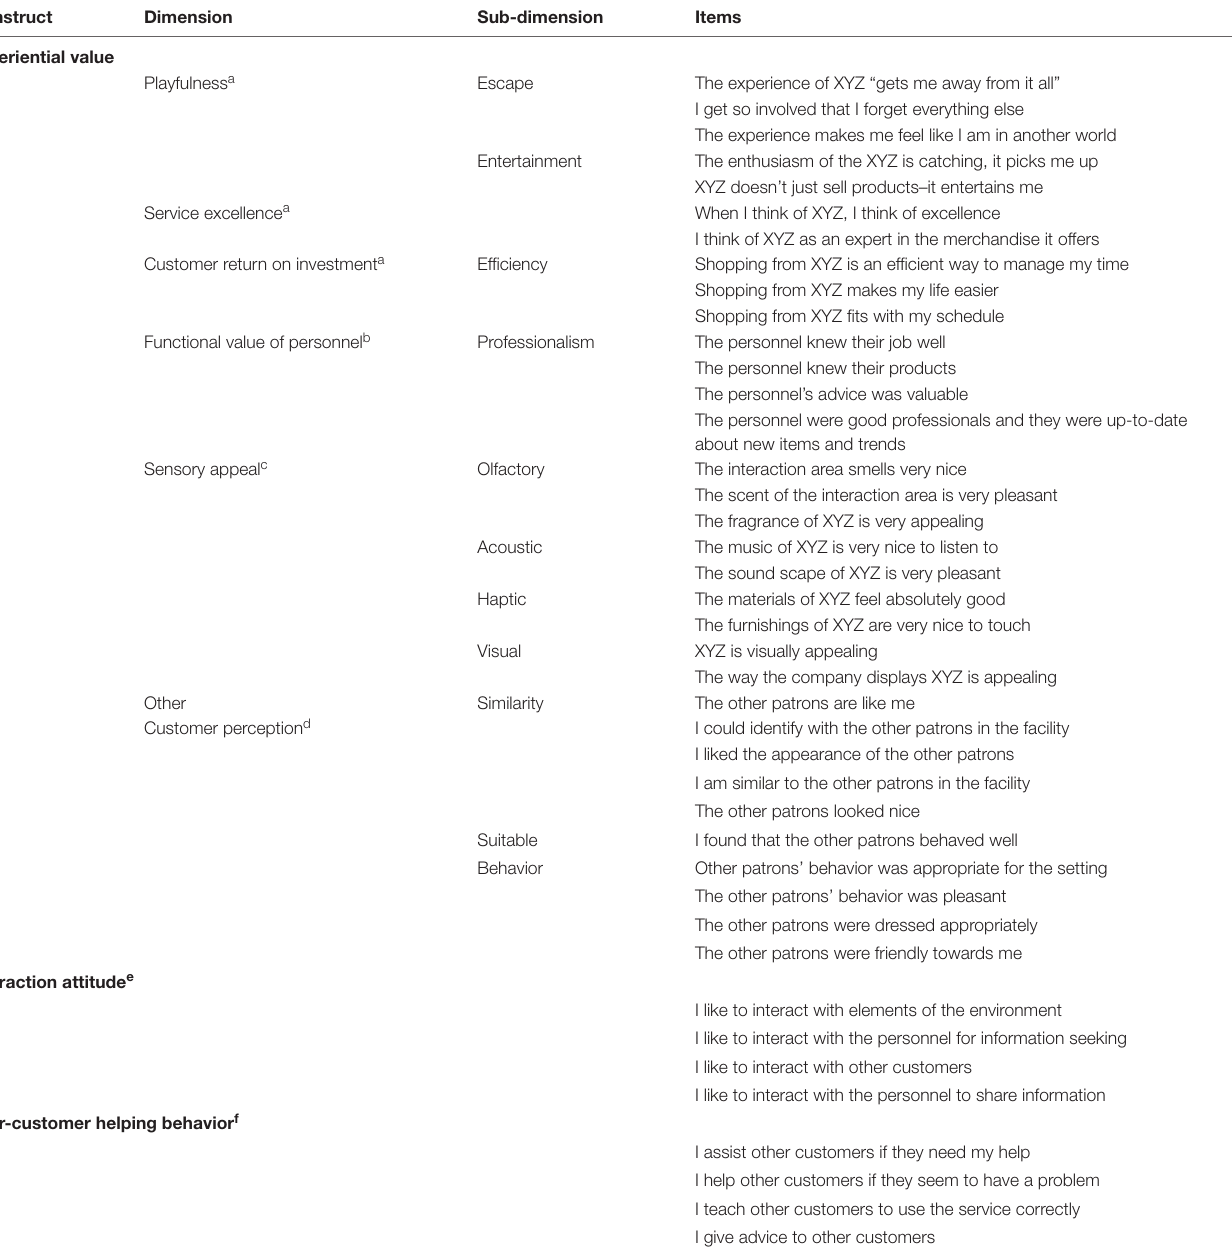
TABLE 1 | Constructs and measurements of experiential value, interaction attitude, and inter-customer helping behavior in multi-actor service ecosystems.